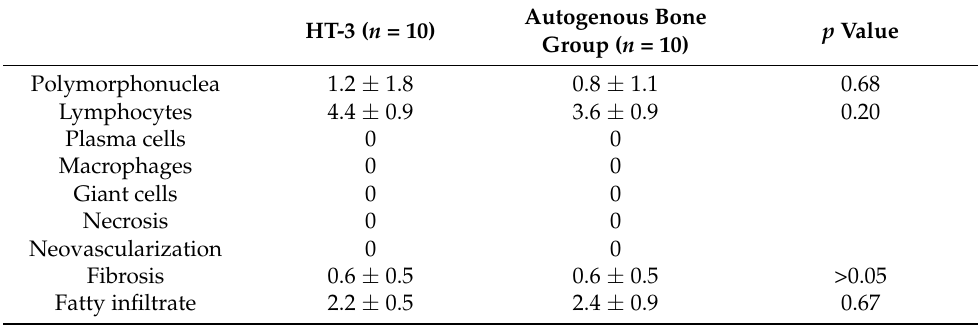
Table 3. Histological findings and irritant-ranking scores according to ISO 10993-6: